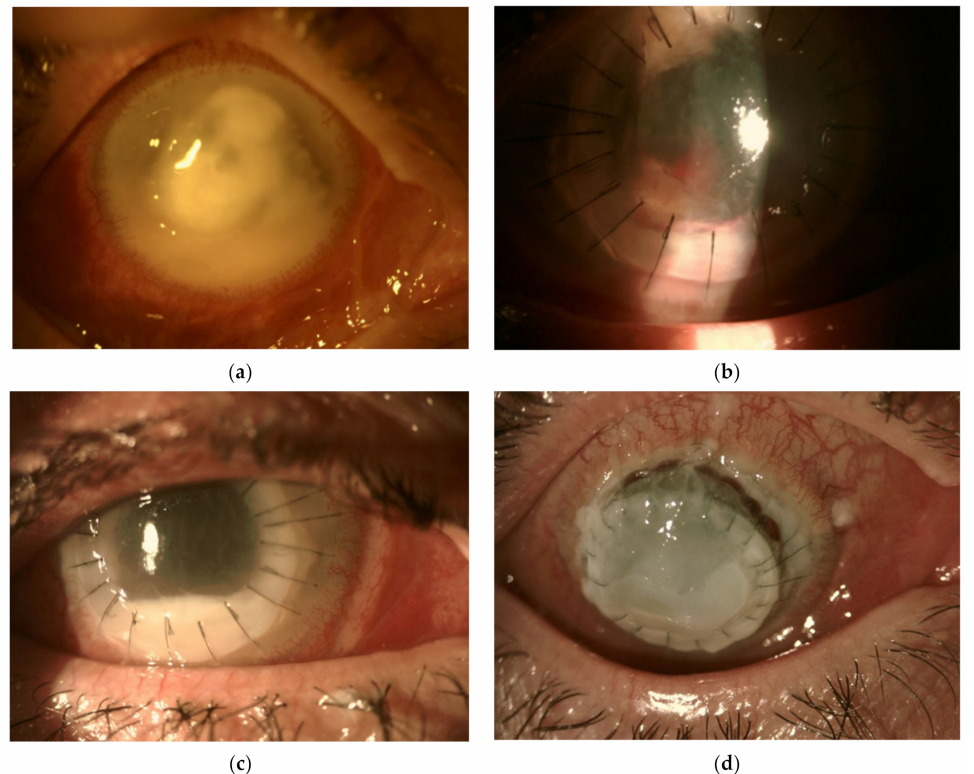
Figure 3. Failure of treatment in a 53-year old patient with severe Fusarium spp. keratitis associated with improper use of contact lenses and extended improper initial multi-drug treatment. ( a ) Admission, seven weeks from the onset of the symptoms and after a period of self-administered treatment with the number of topical (fluoroquinolones, gentamycin) and oral antibiotics (cephalosporins), together with topical steroids. Bacterial cultures taken on admission were negative. ( b ) Recurrence of anterior chamber exudate three days after therapeutic penetrating keratoplasty (TPK) performed shortly after admission, due to progressing tissue melting, despite introduced intensive treatment with topical vancomycin, gentamicin, and ceftazidime, as well as fluconazole and ceftazidime intravenously. Probes taken on the tenth day of hospitalization showed growth of mixed flora, including Corynebacterium spp., Staphylococcus aureus , coagulase-negative Staphylococcus , and Streptococcus mitis , all of which were susceptible to the treatment. However, progression was observed. ( c ) Twelve days after TPK, fungal cultures taken on admission revealed growth of Fusarium spp. Due to hospital internal regulations (amphotericin B was on the list of expensive medications requiring special administrative approval, which could only be obtained after obtaining positive culture), only then was the treatment with topical amphotericin B (AMB) and intravenous, topical, and intracameral voriconazole (VCZ) introduced. ( d ) Thirty days after TPK, melting and luxation of the lens into the anterior chamber requiring lens excision and sutures exchange. Seven weeks after admission, due to continuous progression with corneal tissue melting evisceration was